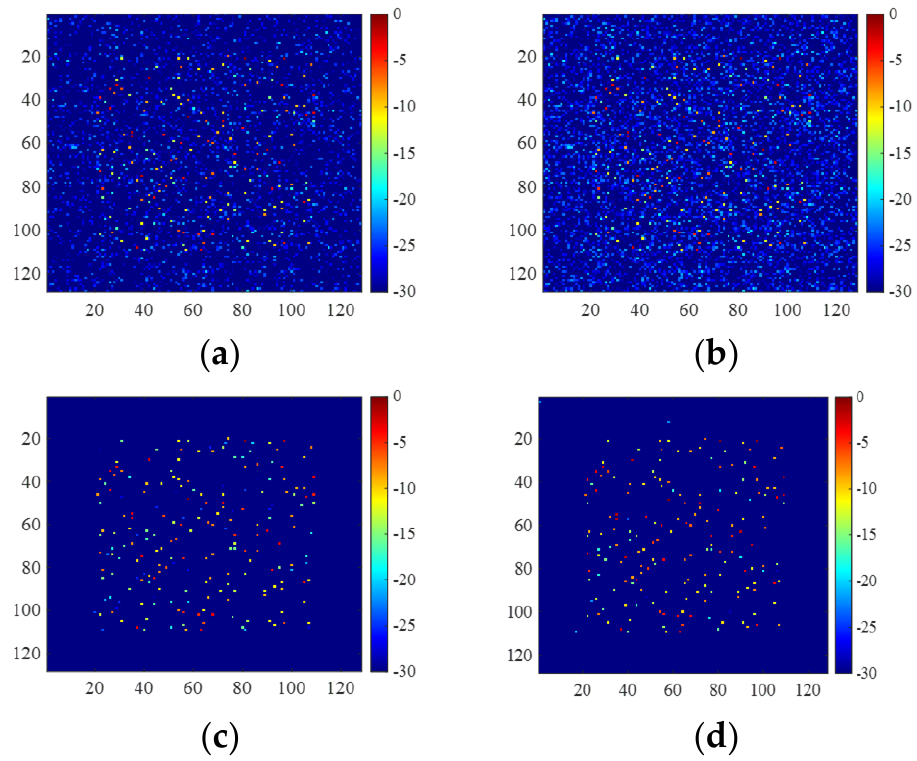
Figure 9. Images of the complete data obtained by ( a ) 2D-FISTA, ( b ) untrained 2D-ADN, ( c ) UNet, and ( d ) trained 2D-ADN. Table 1. Quantitative performance evaluation for the complete simulation Table 2. Quantitative performance evaluation for the complete simulation data.